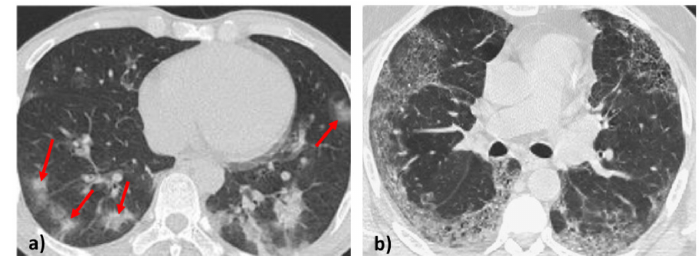
Figure 1. ( a ) represents a CT of the lungs of a patient with COVID-19, in which there are clear traces of GGO indicated by red arrows. ( b ) shows a CT of the lungs of a non-COVID-19 patient with diffuse opacity in the outer parts of the lungs. These images are courtesy of